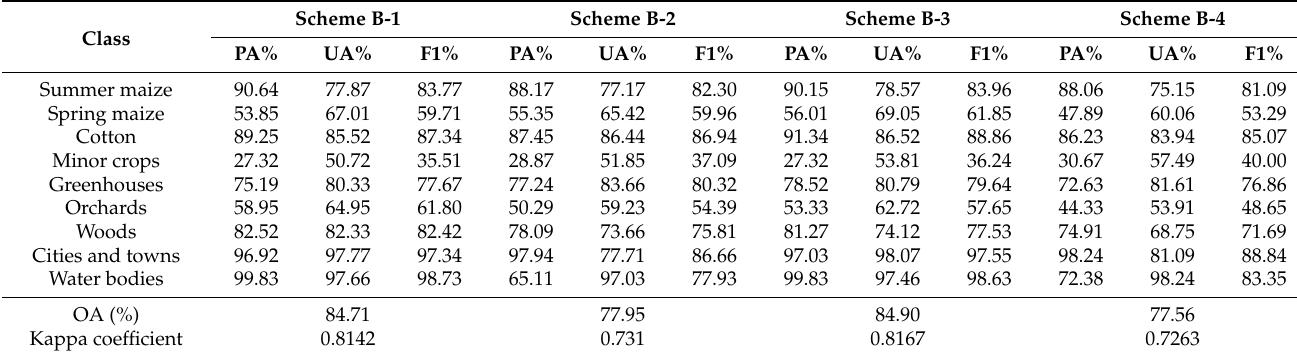
Table 8. Classification accuracy statistics of red edge texture features.